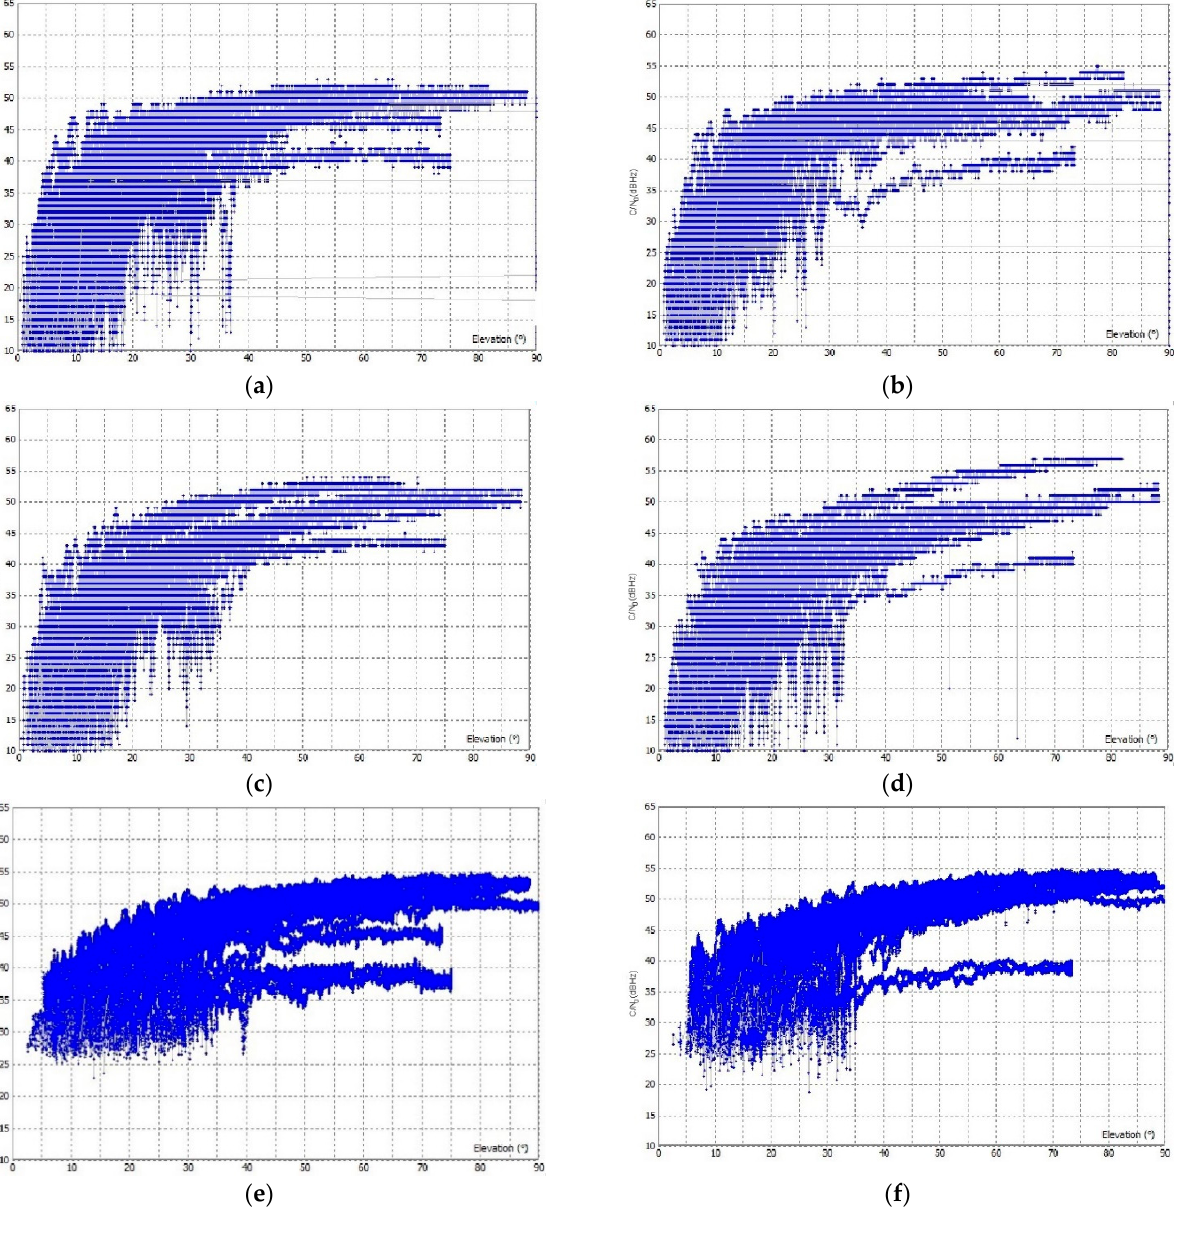
Figure 6. C/N 0 for observations in F1 and F2 frequency in the urban areas: ( a ) F1 C/N 0 for LC − 1, ( b ) F2 C/N 0 for LC − 1, ( c ) F1 C/N 0 for LC − 2, ( d ) F2 C/N 0 for LC − 2, ( e ) F1 C/N 0 for GD − 1, and ( f ) F2 C/N 0 for GD − 1. Table 2. RMSE for multipath error in open-sky and urban